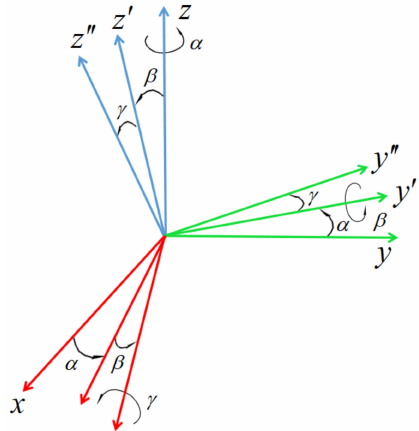
Figure 15. Eulerian